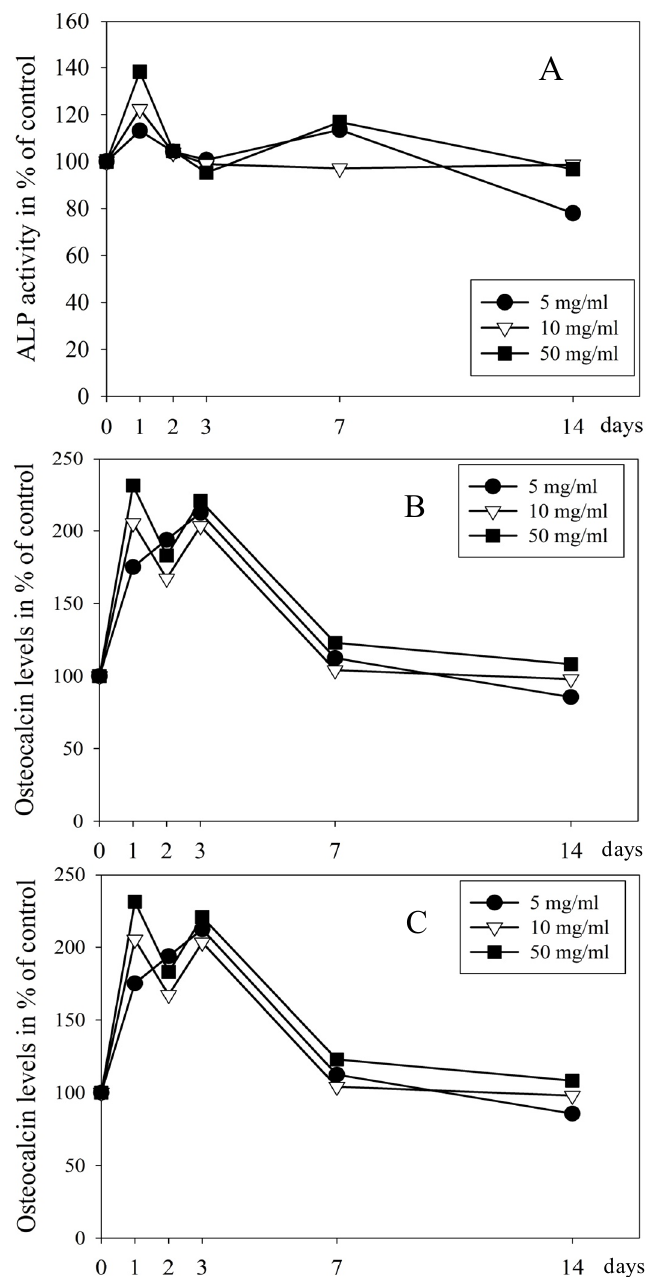
Figure 2. Effect of EMD (5, 10, 50 μ g/mL) on the alkaline phosphatase (ALP) activity ( A ); osteocalcin (OC) ( B ); and collagen type 1 (COL1A1) secretion ( C ) in the cell medium by primary human pulp cells. The data is presented as mean ± SD in percent of untreated cells (100%) at each